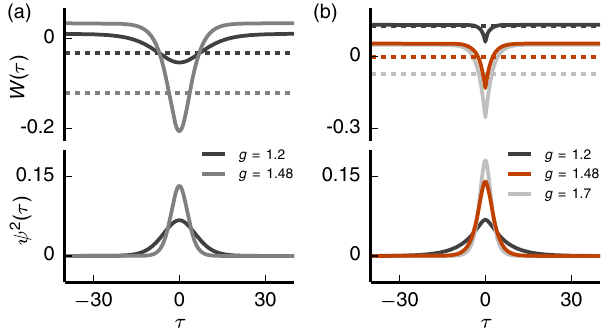
FIG. 2. Ground state of the Schrödinger equation, which determines the Lyapunov exponent. Upper part of vertical axis: Quantum potential W ð τ Þ (solid curve) and ground-state energy E 0 (dashed line) for the autonomous case (a) and the driven case (b) for σ ¼ 0 . 35 . Lower part of vertical axis: Corresponding squared ground-state wave function. The parameters are the same as in Fig. 1 (with the driven case for g ¼ 0 left